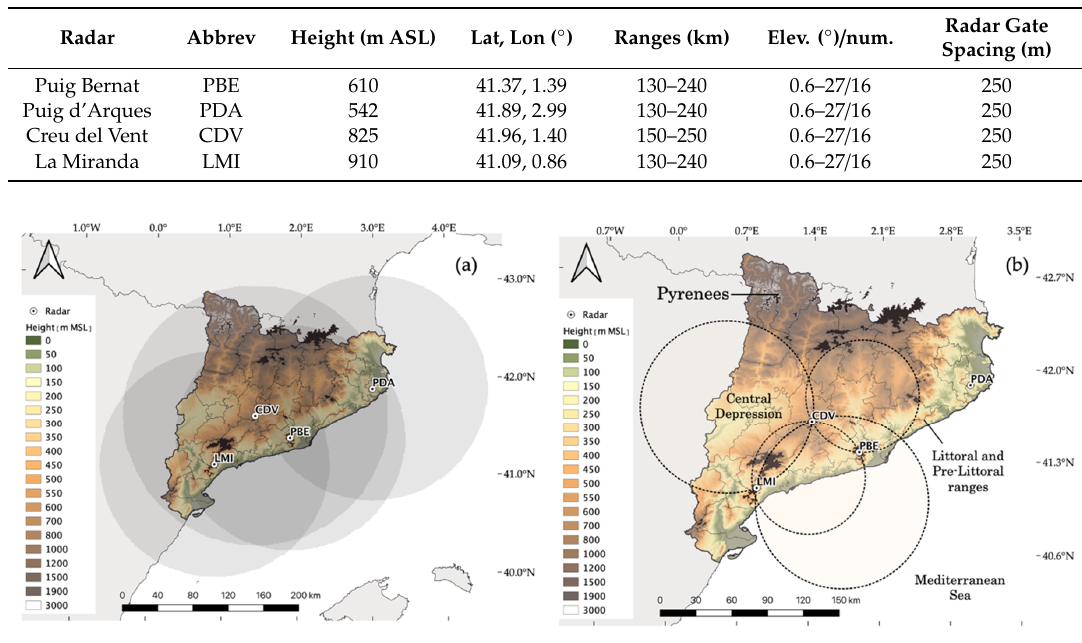
Figure 2. The Meteorological Service of Catalonia radar network, XRAD. ( a ) Spatial coverage (shaded in grey) and topography blockage (areas in black) for 0.6 ◦ elevation angle. All radars have a maximum range of 130 km, except for CDV (central one) which is 150 km. ( b ) Dual-Doppler pairs for the XRAD: CDV-PBE and CDV-LMI. Dotted circles show the dual lobes for a 30 ◦ dual-Doppler beam-crossing angle. Topography is shaded in terrain colors and is indicated in meters. The main topographic features are labeled.